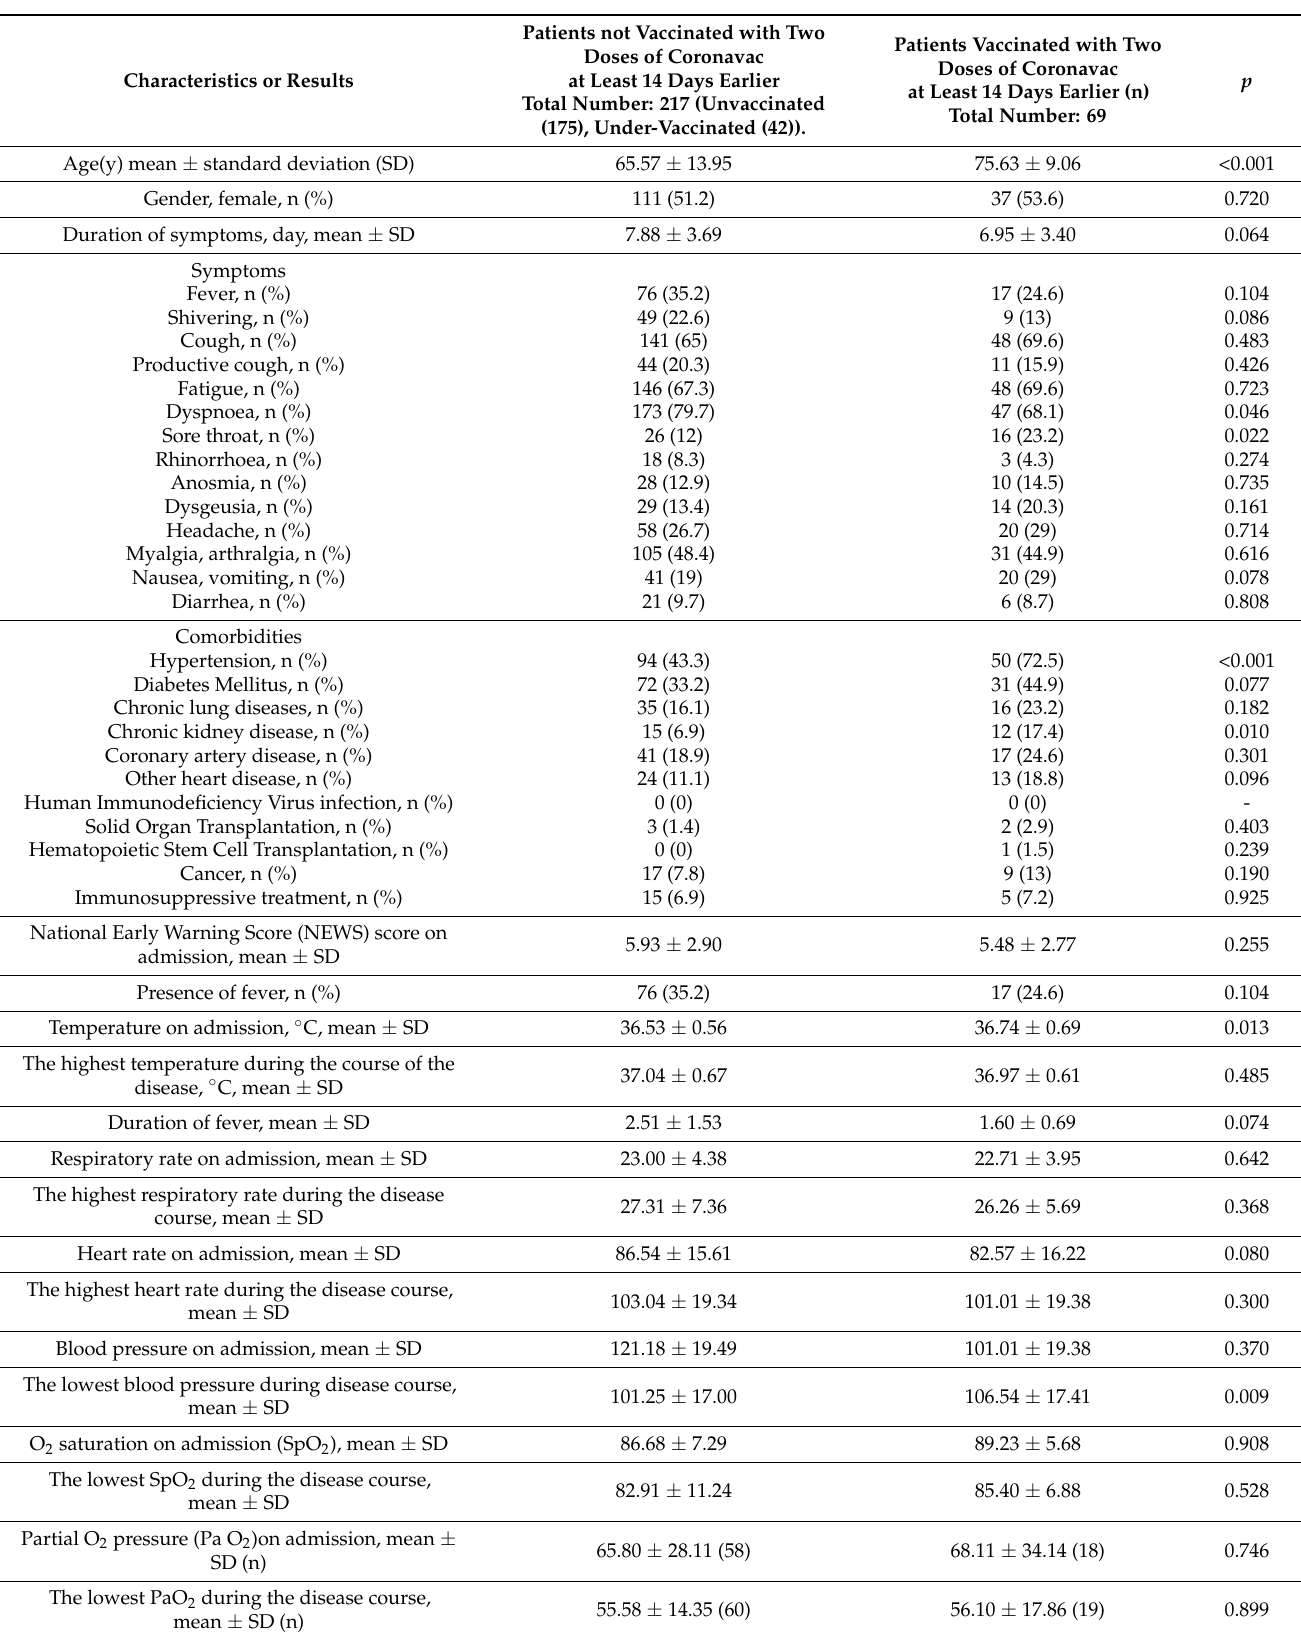
Table 1. Comparison of the clinical and laboratory features and outcomes of hospitalized COVID-19 patients who were either fully vaccinated with Coronavac or